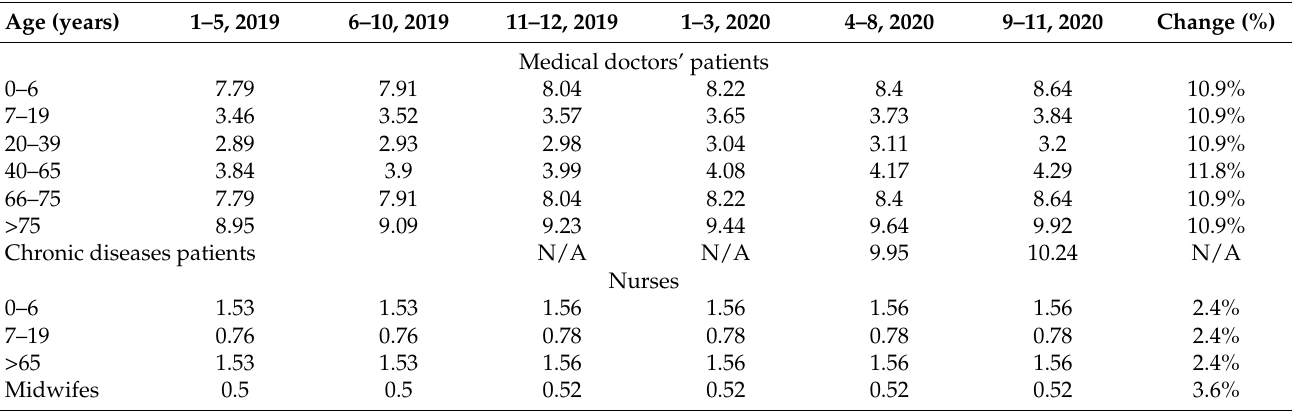
Table A1. Per capita NHF payments to primary health care service providers in the period from Jan 2019 until November 2020. All amounts in EUR. The change of fees through the period in EUR and